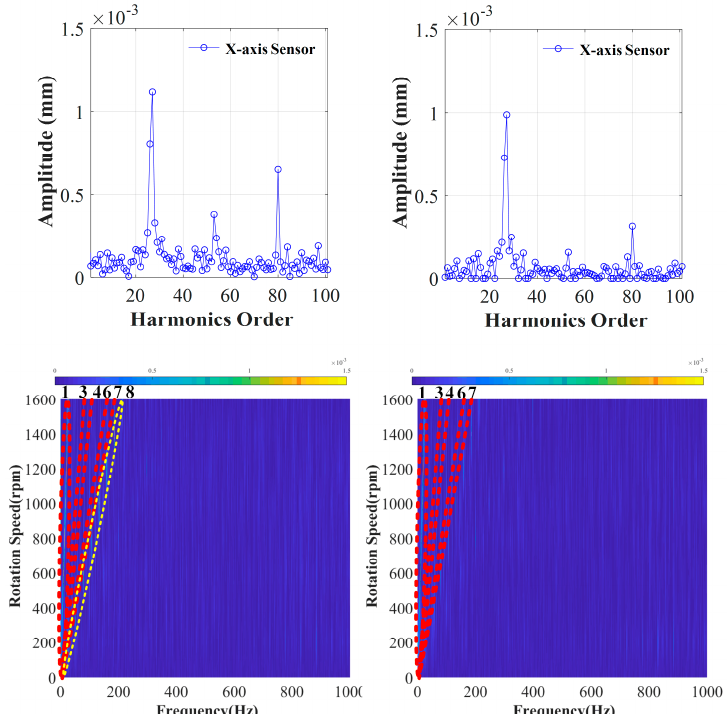
Figure 11. The displacement measurement results of permanent magnet machines with two different slots.